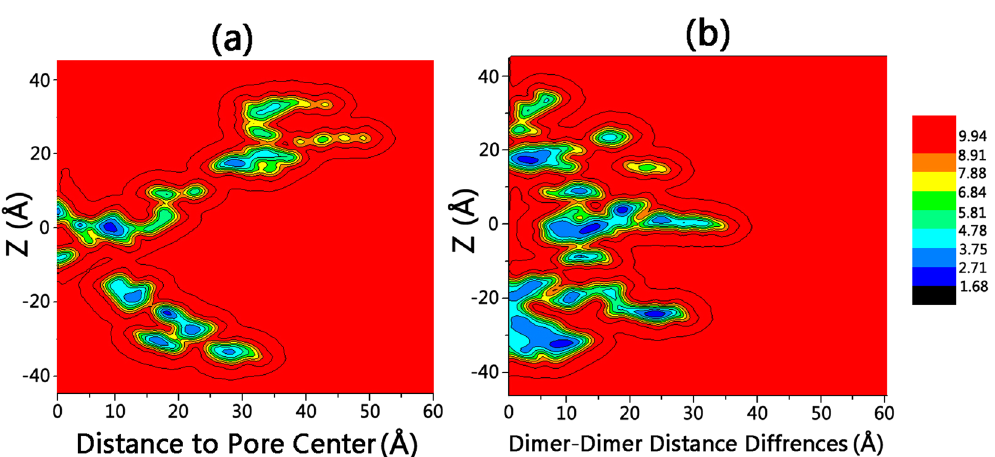
Figure 3. Two-dimensional (2D) free energy landscape for the release of cytochrome C from Bax oligomeric pores at the membranes. Z distance: vertical distance to pore center alone the pore axis. Left panel: X-axis: distance of the center of mass of cytochrome C to the center of pore. Right panel Characterizing of Bax pore elliptical shape by the differences between the longest and shortest distance between the center of masses of two opposite dimers in hexagon vertices. A larger dimer-dimer distance difference refers to a larger shape change of the pore from regular hexagon.